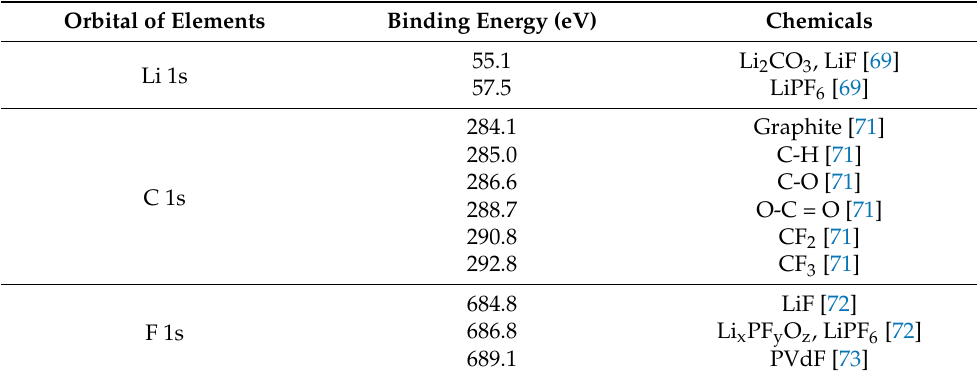
Table 5. The assignment of the XPS peaks [70].